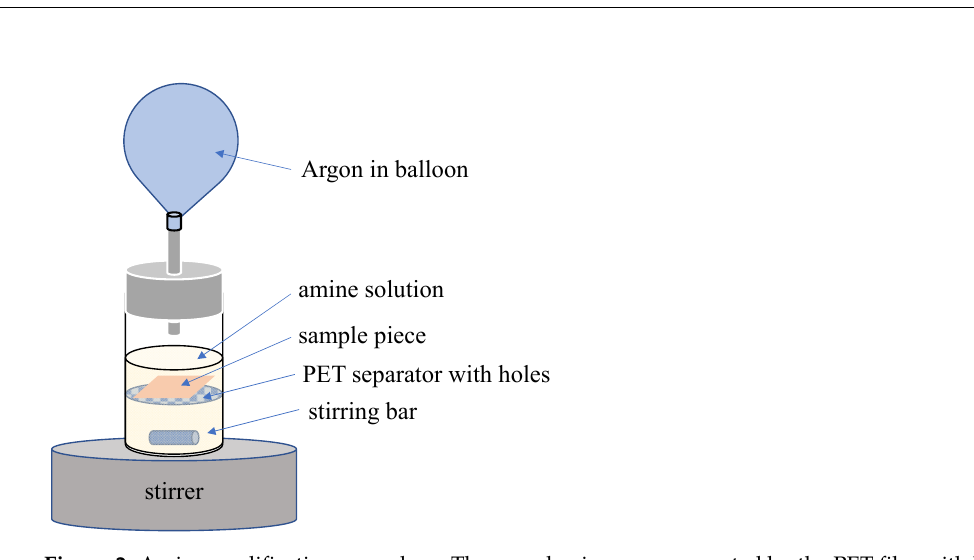
Figure 2. Amine modification procedure. The sample piece was separated by the PET film with holes to prevent collision with the stirring bar.